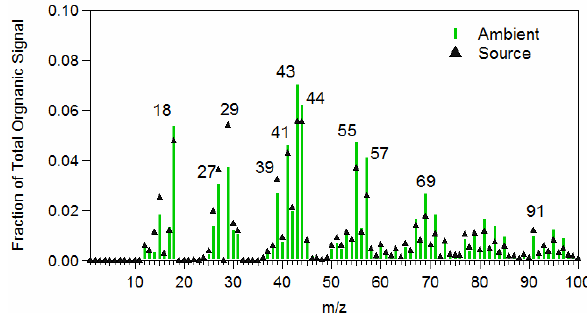
Figure 8. Comparison between the average mass spectrum from the 4 chamber Fig. 8. Comparison between the average mass spectrum from the 4 experiments and the average mass spectrum on December 11 th 2012 9:00-12:00 am. The chamber experiments and the average mass spectrum on 11 Decem- angle θ between the two spectra is equal to 13.6 degrees. ber 2012, 09:00–12:00LT. The angle θ between the two spectra is equal to 13.6